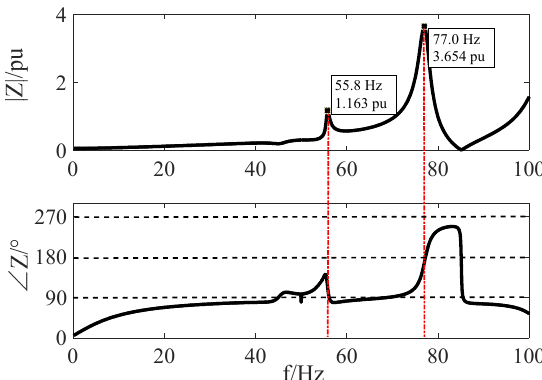
Figure 6. Input-impedance characteristics of 0.69 kV node in wind farm 4.